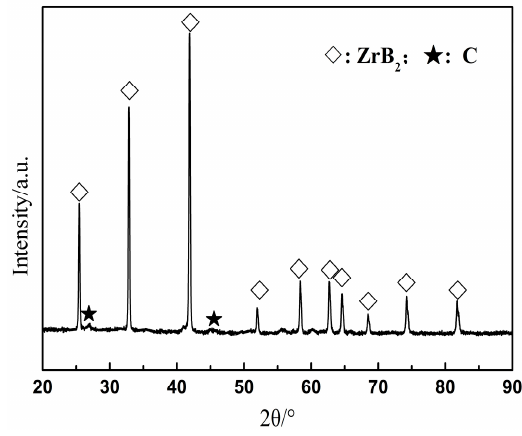
Figure 7. X-ray diffraction (XRD) patterns of ZrB 2(nano) -5 wt % CNTs composites sintered at 1600 °C.